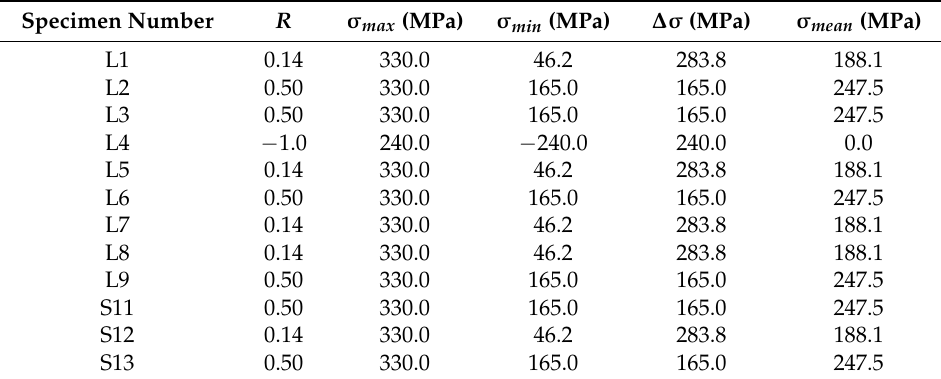
Table 4. Test envelope, from [16], for small cracks growth in a locomotive steel.